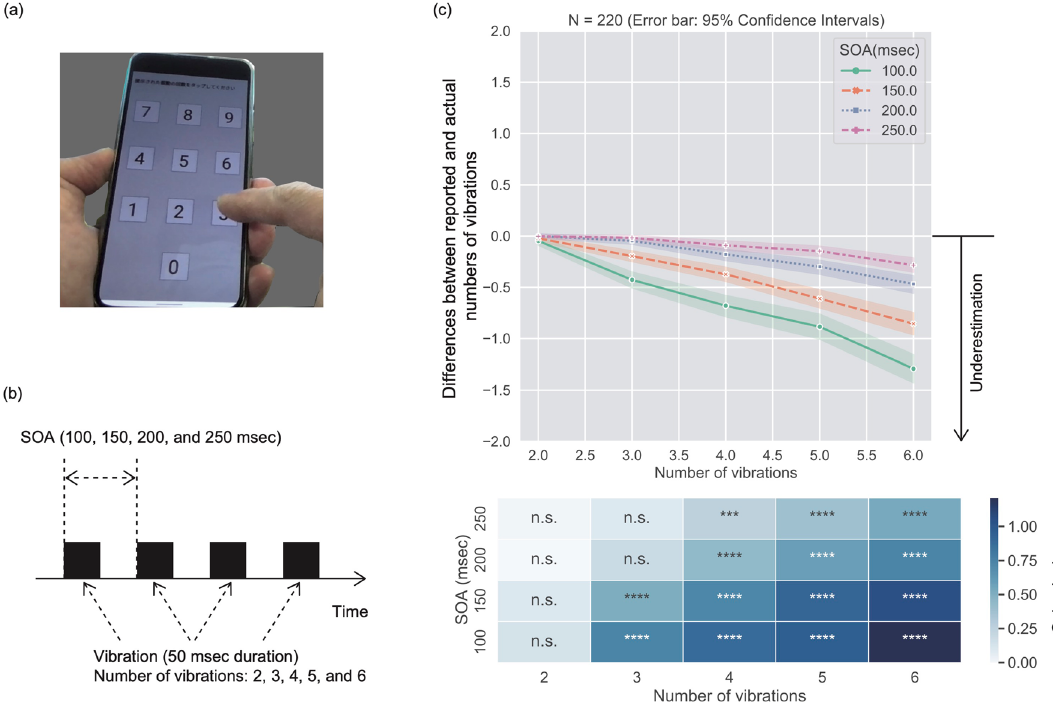
Figure 1. ( a ) A photo of our experimental scene. ( b ) A schematic description of stimuli. ( c ) Upper: Mean difference between actual and reported numbers of vibrations as a function of the number of actual vibrations. The difference was calculated by subtracting the actual from the reported numbers of vibrations. Thus, positive and negative values for the difference denote overestimation and underestimation, respectively. Lower: Heatmap of Cohen’s d for each age band. Asterisks (*p < 0.05, **p < 0.01, ***p < 0.001, ****p < 0.0001) denote the significance level (with correction by the Holm’s method) of one-sample t-tests for the mean difference with an array of zeros. n.s.